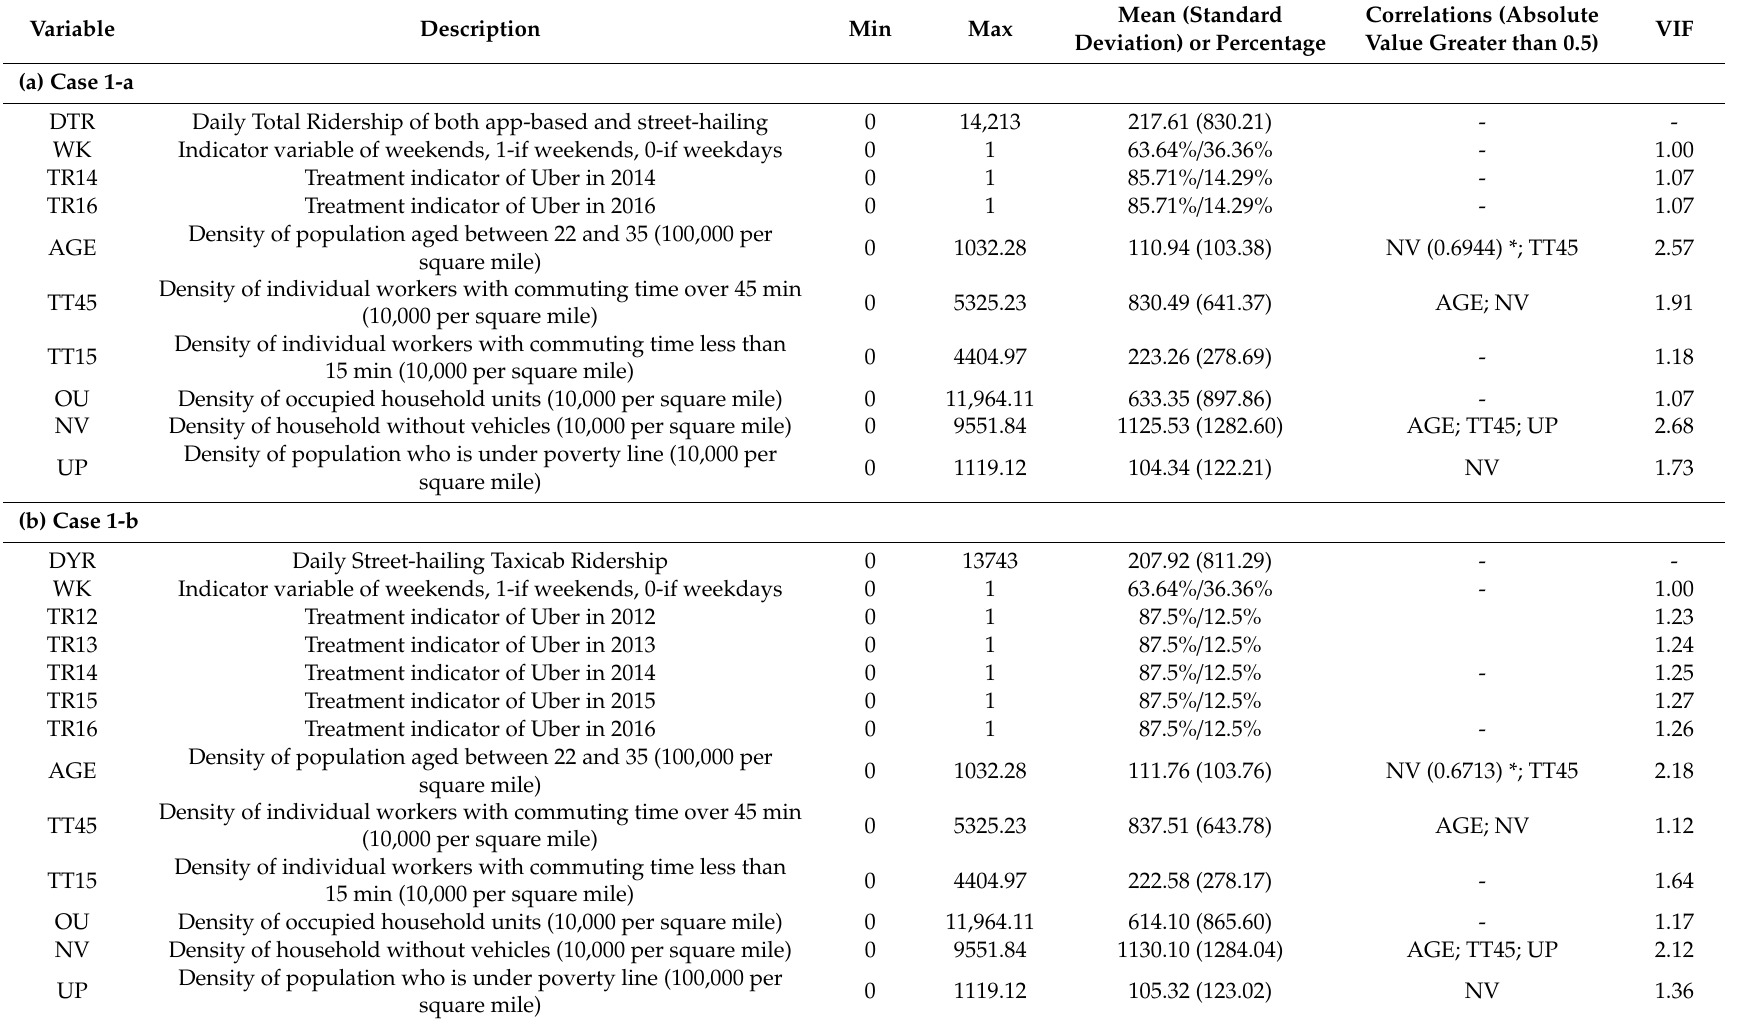
Table 1. Summary statistics of variables for all three